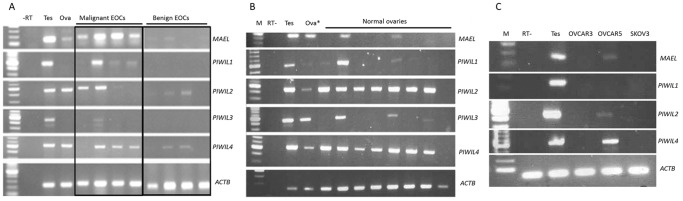
piRNA pathway gene expression in human normal ovaries and ovarian cancers.RT-PCR analyses of PIWIL1-4 and MAEL expression in (A) malignant EOC, benign ovarian cancers (B) normal ovaries and (C) ovarian cancer cell lines. This is a representation of 4 out of 25 malignant EOC and 19 benign ovarian cancer tissues. Increased expression of PIWIL1, 2, 4 and MAEL, but not PIWIL3, are found in malignant cancers compared to benign tumors. All normal ovaries show PIWIL2 and PIWIL4 expression but only some have PIWIL1, 3 and MAEL expression. No endogenous PIWIL1, 2, 4 and MAEL expression is detected in OVCAR3 and SKOV3 cells. Ova* indicates tissue from a 20-year old pre-menopausal ovary while other ovaries are from individuals aged 44–76 years old.